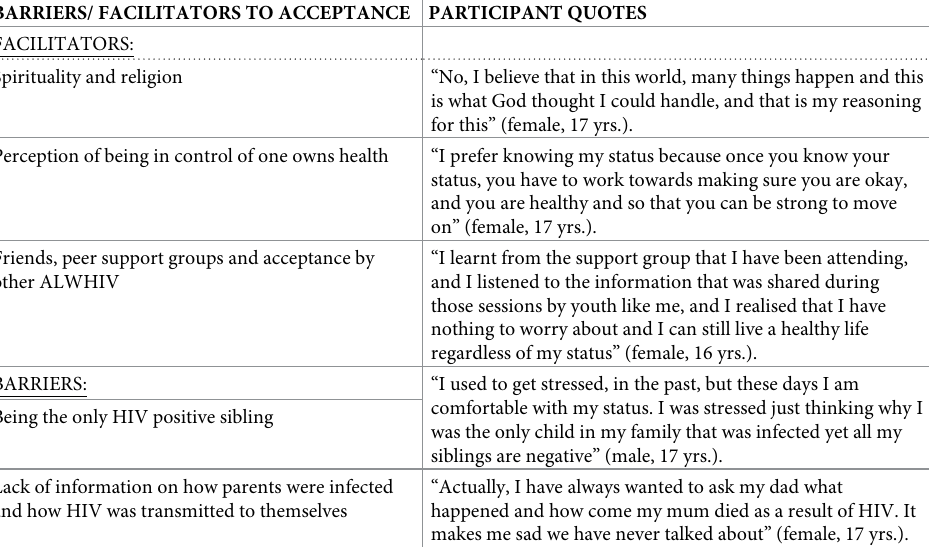
Table 1. Barriers and facilitators of coping after disclosure of HIV